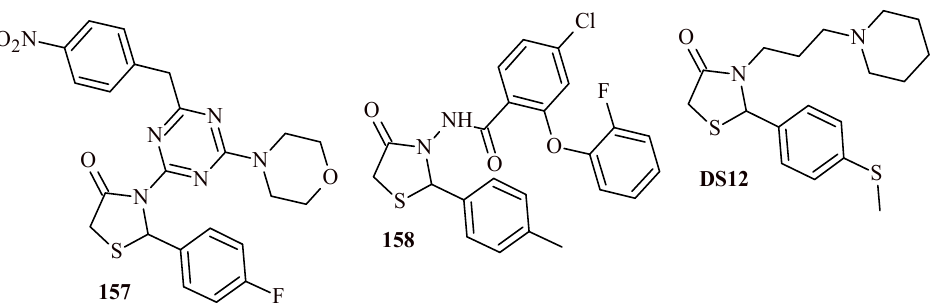
Figure 58. The 2-aryl thiazolidin-4-ones with cerebrovascular protection properties and used in neurological disorders.